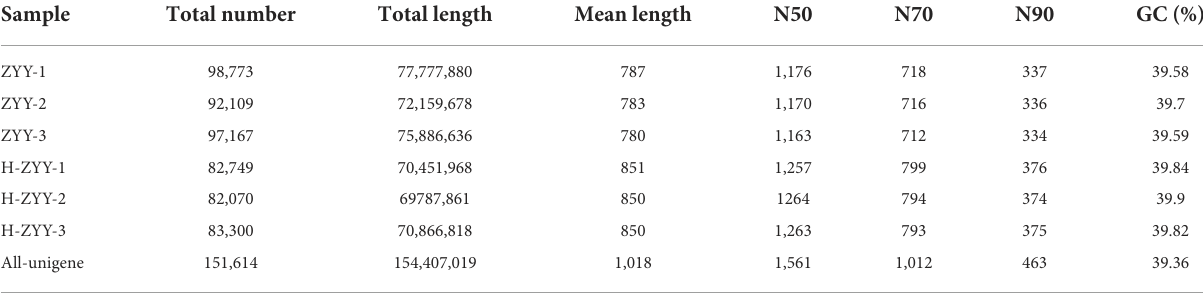
TABLE 3 Unigene quality index statistics.